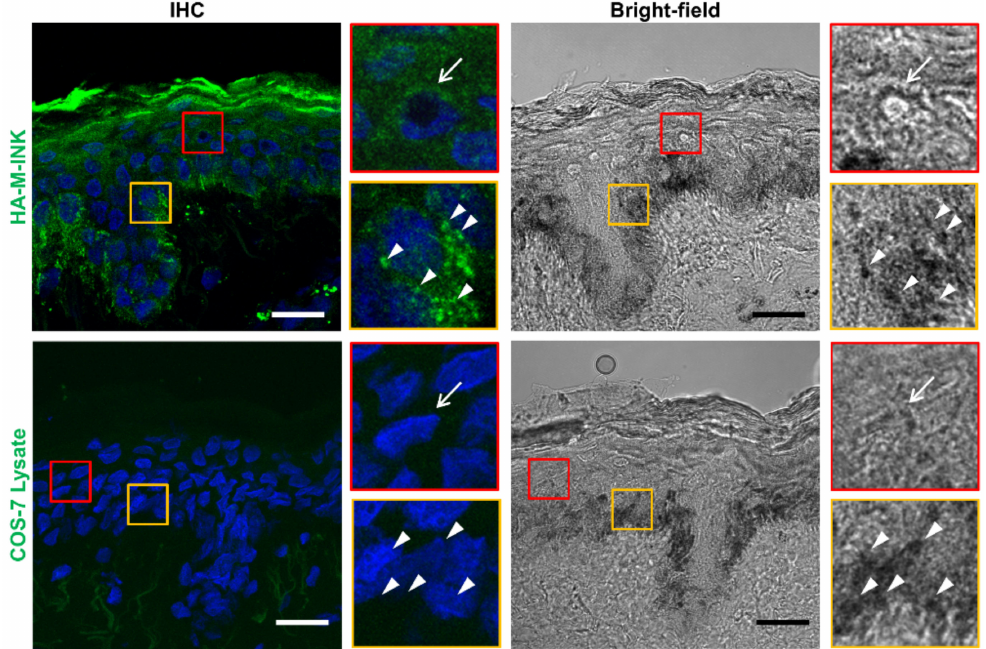
Figure 3. Immunohistochemical (IHC) staining images of melanin in human skin tissue by HA-M-INK staining. Skin sections of phototype IV were stained with HA-M-INK lysates or COS-7 lysates as a control (green), and with DAPI for nuclear counterstaining (blue). The red insets are magnified views of the boxed areas to show the melanin distribution (melanin cap) in the spinous layer (white arrows). The yellow insets are magnified views of the boxed areas to show the melanin distribution in the basal layer (white arrowheads). HA-M-INK staining colocalized with black spots of melanin on bright-field images. Note that untransfected COS-7 cell lysates showed no positive signals. Scale bars = 20 µ m. To determine whether the HA-M-INK signals in the skin samples described above correspond to melanin located within melanocytes or to those transferred from melanocytes to keratinocytes, skin sections were co-treated with HA-M-INK lysates and antibodies against Pmel, c-KIT protein (a melanocyte surface receptor), and desmoplakin 1 (DP-1, an intercellular adhesion molecule in keratinocytes). The results show that HA-M-INK colocalized with c-KIT-positive melanocytes as well as DP-1-positive keratinocytes in the vicinity of melanocytes (Figure 4A, red inset in the top row). By contrast, most of the Pmel-positive signals were observed in the c-KIT-positive melanocytes; however, only a few positive signals were detected in the DP-1-positive keratinocytes (Figure 4B, red inset in the bottom row), indicating that the anti-Pmel antibody fails to e ffi ciently detect melanin transferred to keratinocytes. Thus, our results indicate that the newly developed HA-M-INK can individually detect melanin present in melanocytes and